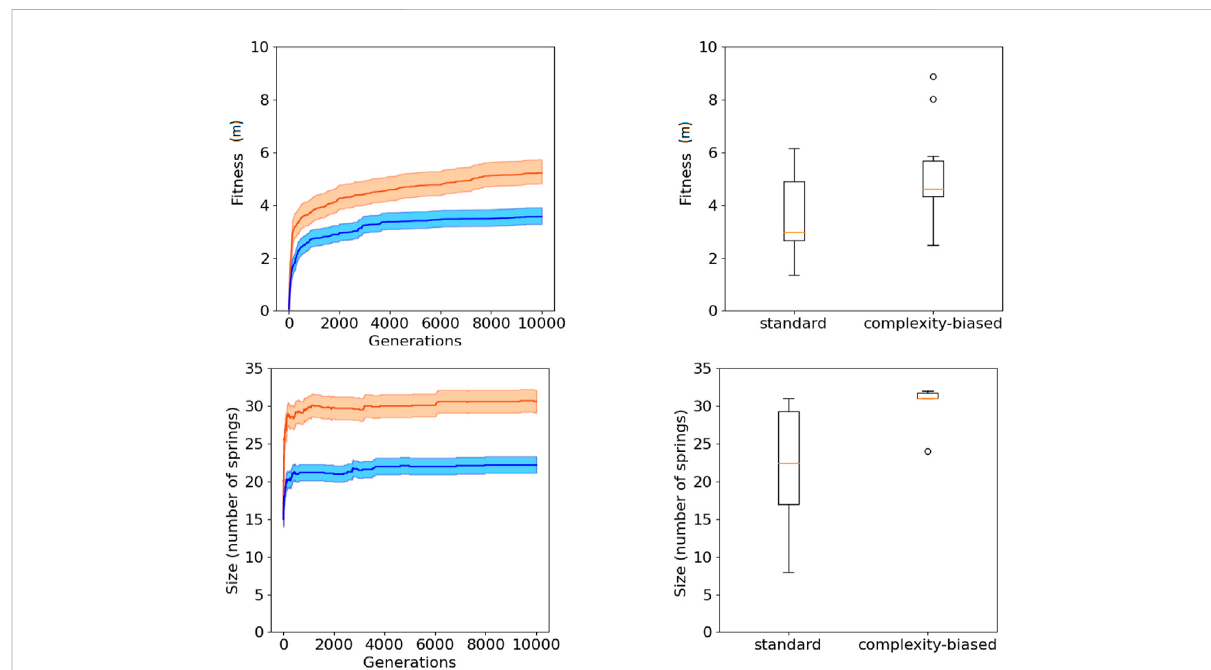
FIGURE 2 Fitness (top) and phenotypic complexity (bottom) in the case of the experiments performed with the (20 +20) evolutionary strategy. The data showninblueandredcorrespondtotheexperimentsperformedwiththestandardandcomplexity-biasedalgorithm,respectively.Datacollectedby running 10 replicationsof each experiment. Mean and 75% bootstrapped con fi dence intervals of the mean (shadow area) across 10 replications. The top-left fi gure shows the performance of the best individuals of each generation, averaged over 10 replications. The top-right fi gure shows the distribution of performance of the best 10 robots obtained in 10 corresponding replications of the experiment. The bottom-left fi gure shows the average phenotypic size of the best robots across generations. The bottom-right fi gure shows the distribution of phenotypical size of the 10 best robots obtained in the 10 corresponding replications of the experiment. The boxes represent the interquartile range of the data and horizontal lines